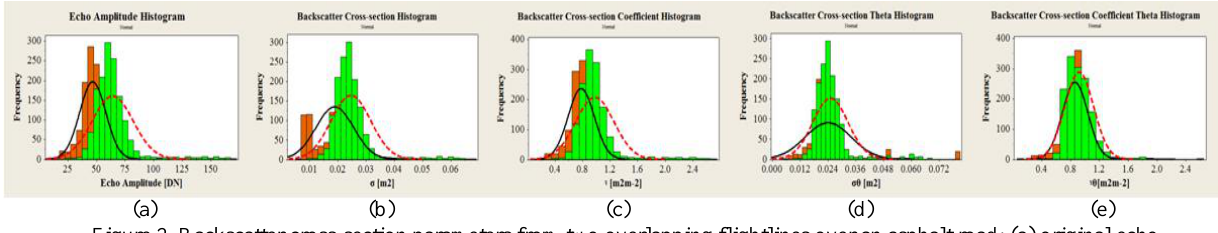
Figure 2. Backscatter cross-section parameters from two overlapping flightlines over an asphalt road: (a) original echo